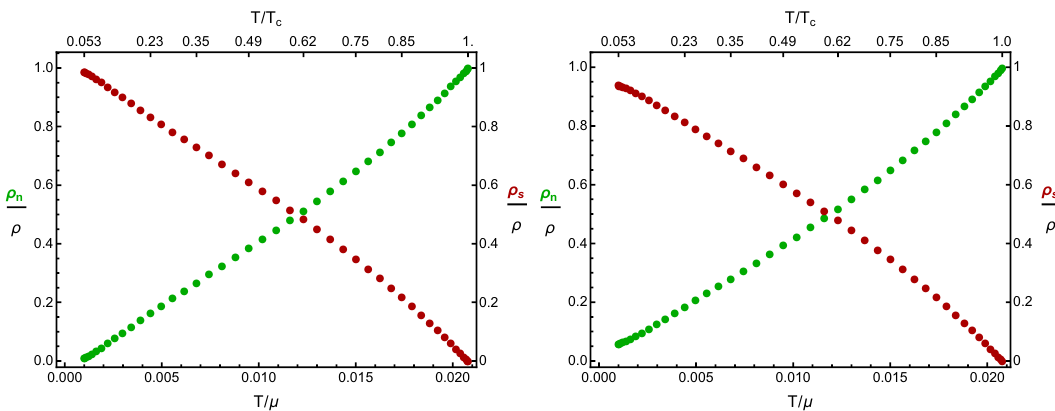
Figure 1 . The normal and superfluid densities ρ n and ρ s as function of the temperature. Left : translational invariant theory. Right : model with broken translations, α/µ = 1 / 10 .